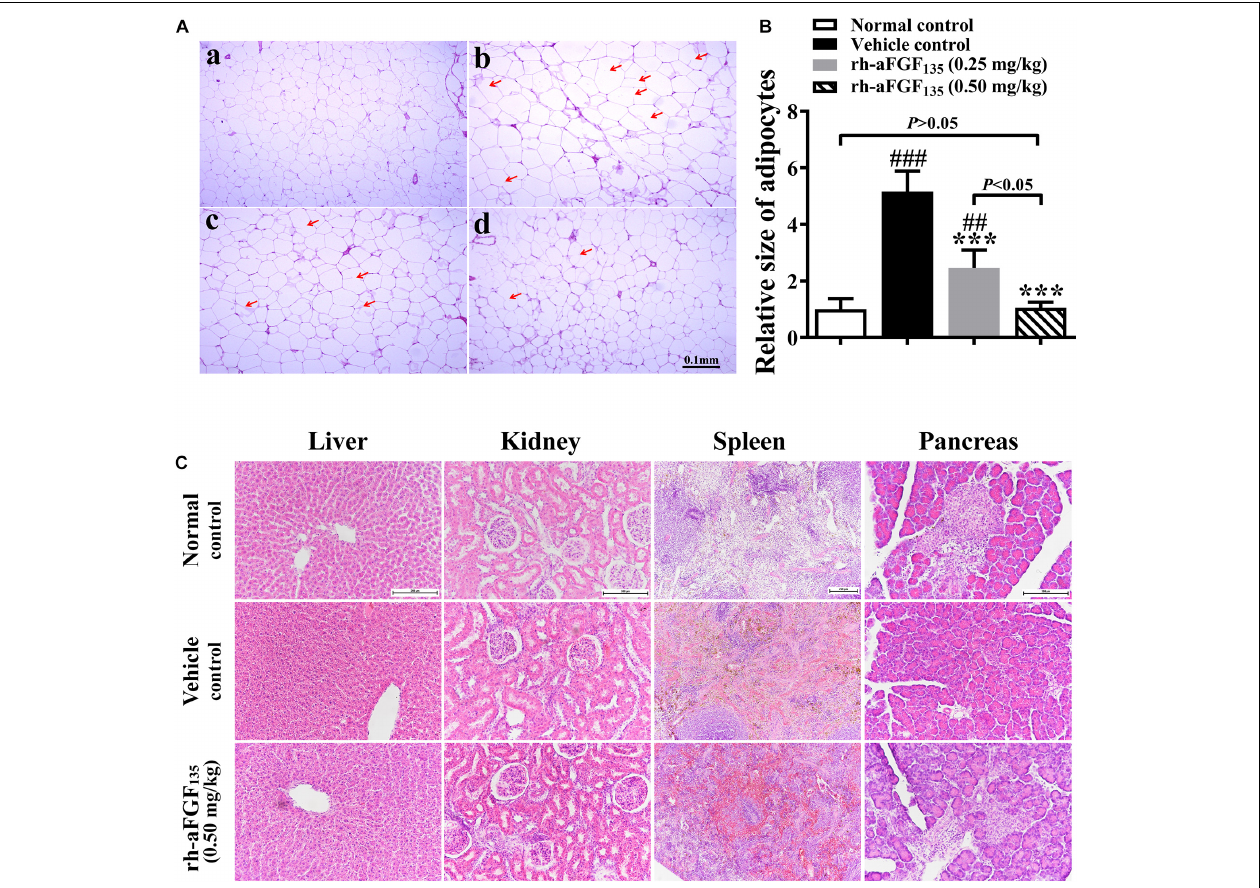
FIGURE 5 | Effects of rh-aFGF 135 on the organs of diabetic ZDF rats. (A) The effect of rh-aFGF 135 on the pathology of adipose tissue (100 × ) in diabetic ZDF rats (H&E staining). (a) Normal group. (b) ZDF rats treated with vehicle. (c) ZDF rats treated with rh-aFGF 135 (0.25 mg/kg). (d) ZDF rats treated with rh-aFGF 135 (0.50 mg/kg). The dead adipocytes were marked with red arrows. (B) Statistical analysis of relative size of adipocytes. (C) H&E staining of liver (200 × ), kidney (200 × ), spleen (100 × ), and pancreas (200 × ) in diabetic ZDF rats treated with rh-aFGF 135 . Compared to normal control, ### P < 0.001, ## P < 0.01; Compared to vehicle control, *** P < 0.001, n =